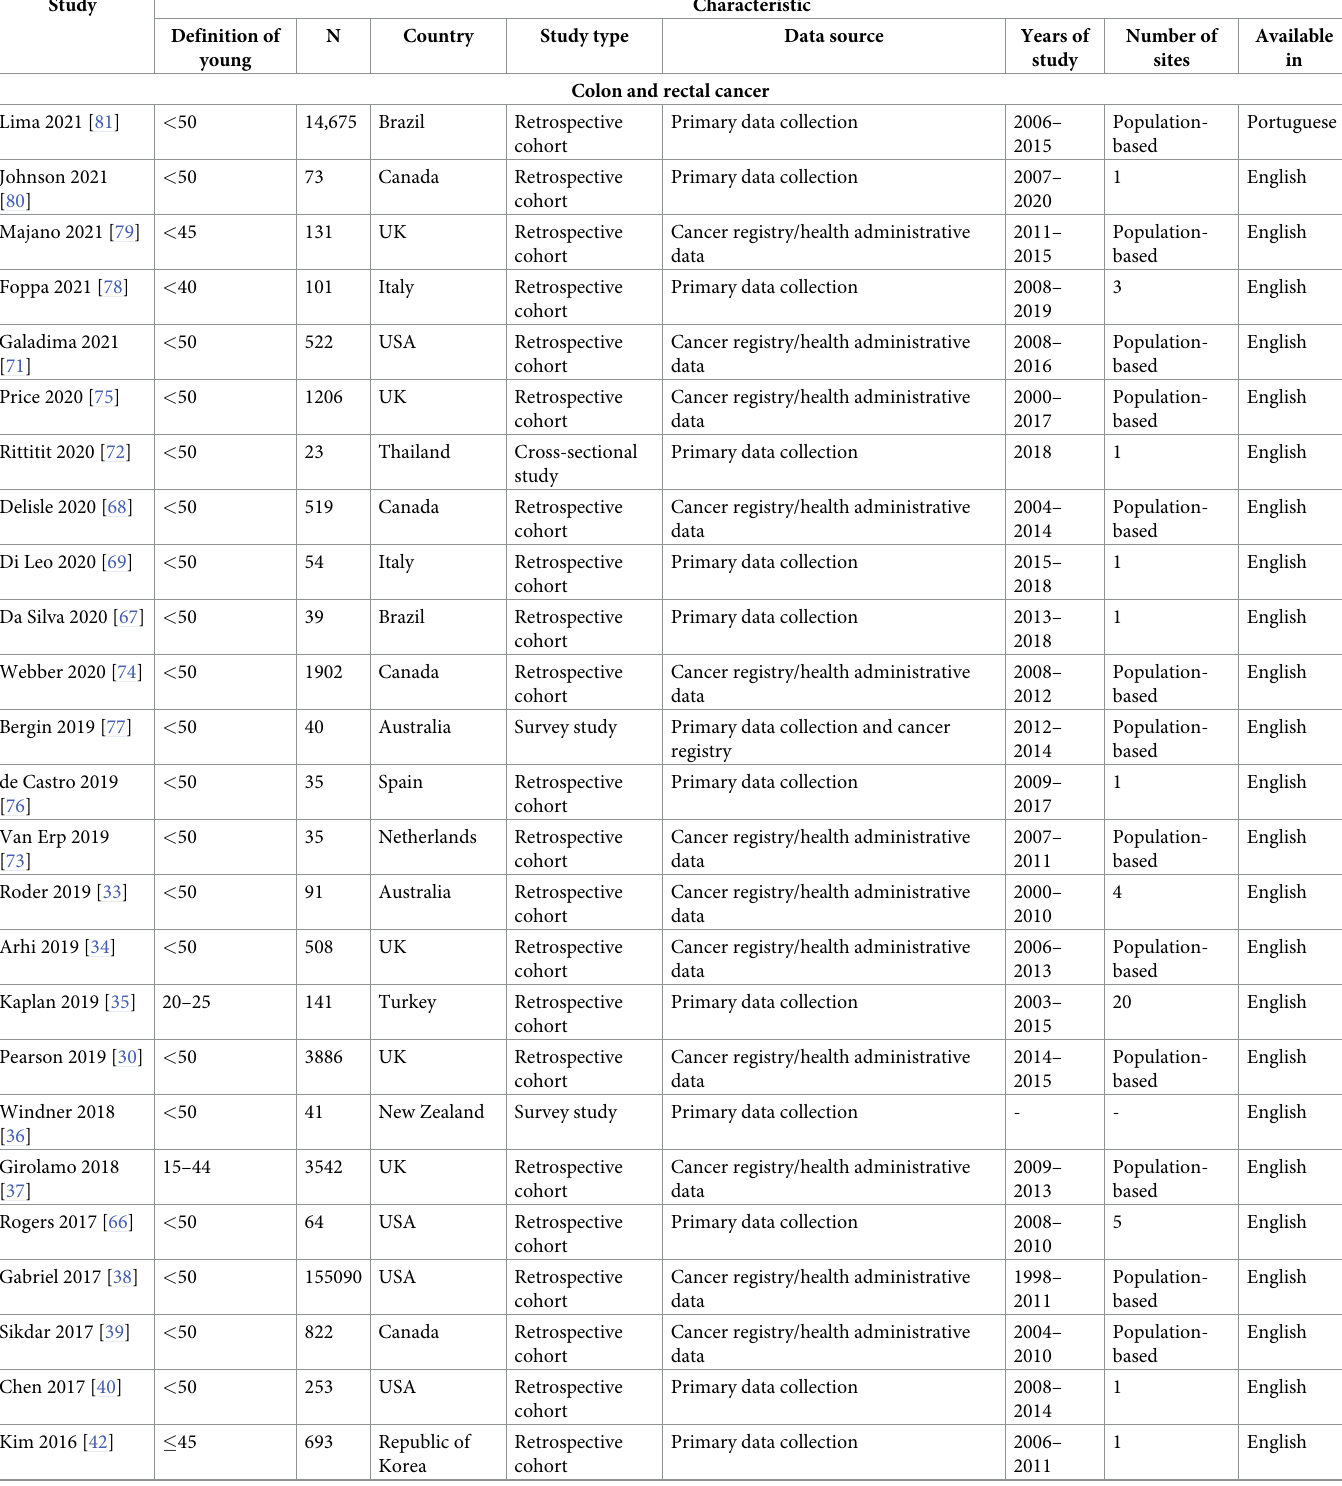
Table 1. Characteristics of included studies (n = 55)